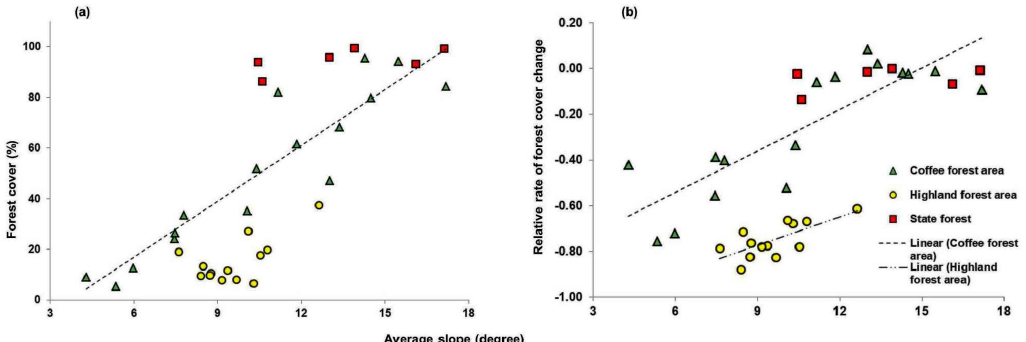
Figure 4. Correlation between forest cover or relative change and average slopes in kebeles in coffee and highland forest areas, and state forest blocks of Gera. The linear trend lines are included where the p -values for Spearman’s rank correlation tests are <0.05. The y-values are percentages of forest cover in 2010 ( a ) and relative rates of forest cover change during 1973–2010 ( b ) while the x-values are average slopes for the coffee areas (excluding Chira town) and highland area kebeles, and the state forest blocks.